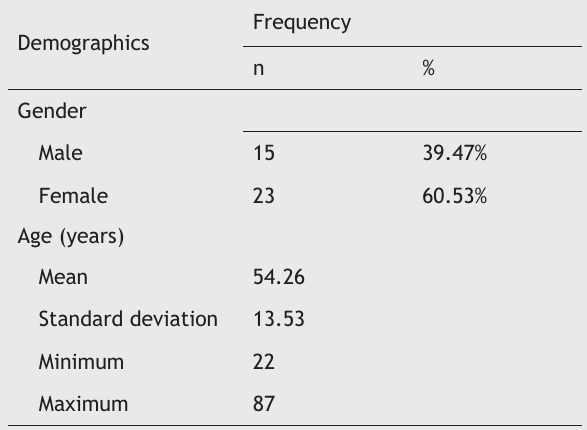
Table 1 Sample characteristics.